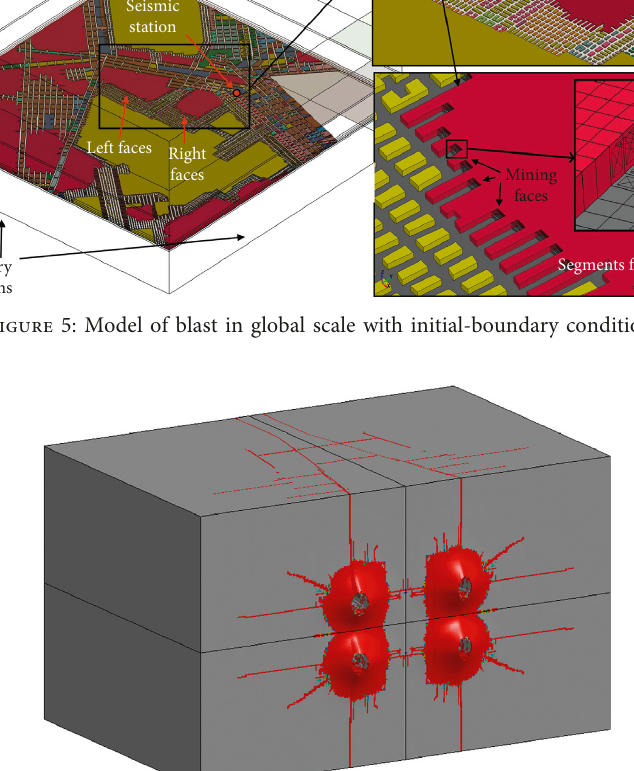
0.1ms. (b) t 0.2ms. (c) t 0.3ms. (d) t (cid:31) (cid:31) (cid:31) (cid:31)